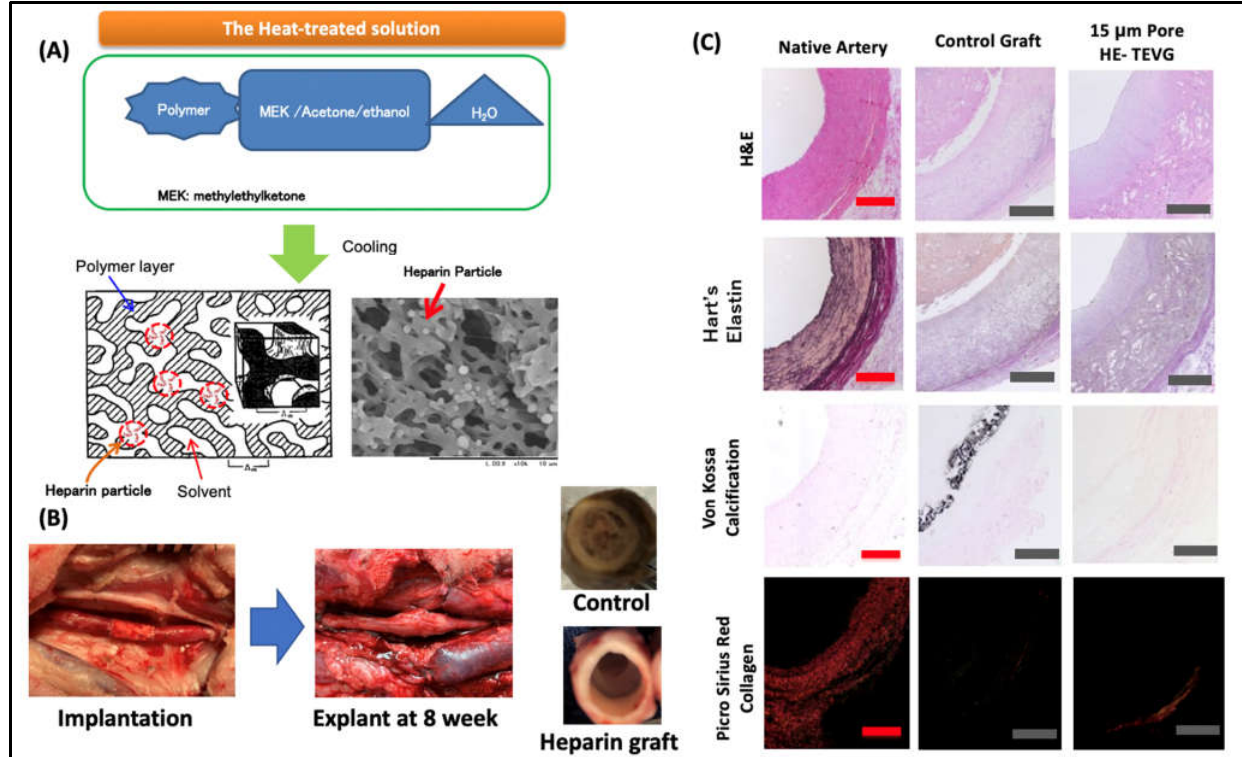
Figure 1. Manufacturing process of heparin-eluting graft: ( A ) Heparin-eluting TEVGs were created with an outer poly-ε- caprolactone (PCL) electrospun nanofiber layer with a 15 μm average pore Scheme 50. poly(l-lactide-co-ε-caprolactone) copolymer (PLCL). SEM showed the inner heparin eluting layer; ( B ) Surgical implantation of TEVG to sheep carotid artery, 3 out of 5 Control grafts were occluded within 1 week. On the other hand, heparin-eluting grafts were obvious throughout the observation period; ( C ) Histological analysis of 15 μm TEVG and occluded control TEVG, red bar = 200 μm, grey bar = 500 µ m. HE, heparin-eluting; TEVG, tissue-engineered vascular graft. Adopted with permission from Shinoka et